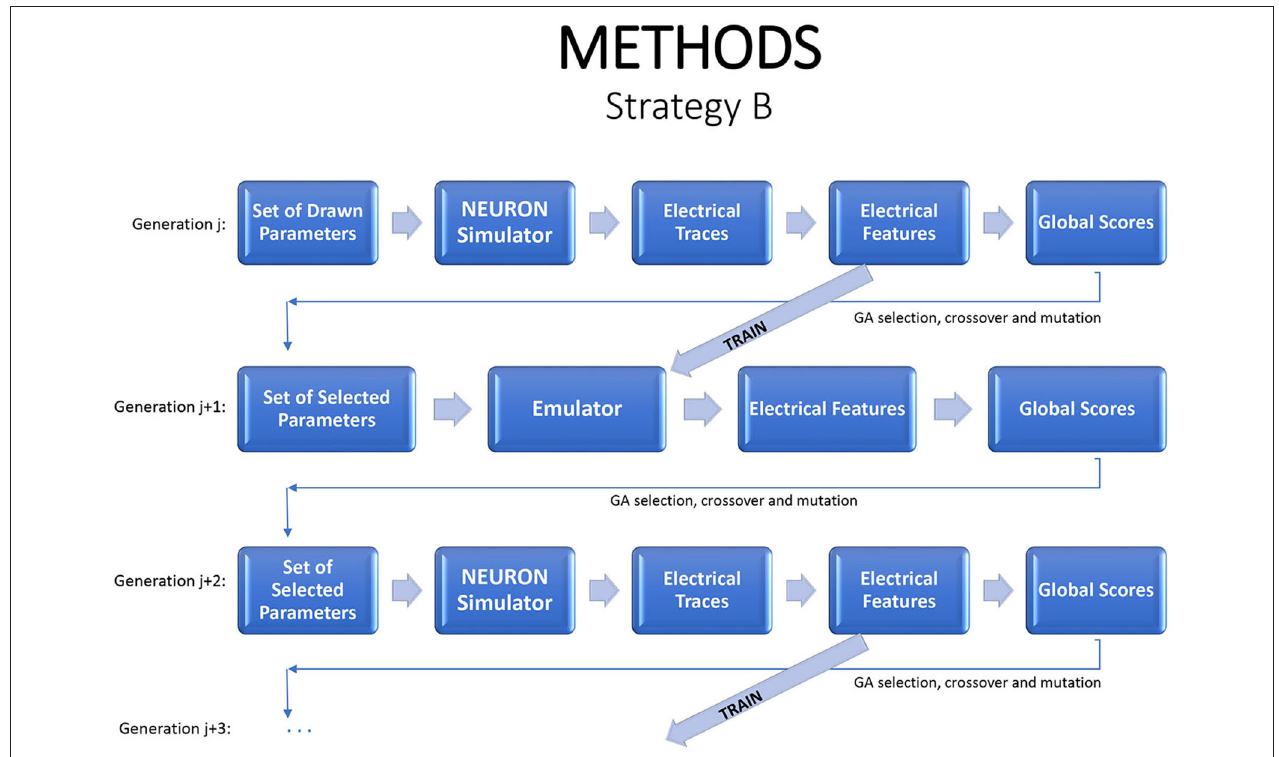
FIGURE 3 | A strategy for a modified genetic algorithm, simulating the individuals in one generation, using them to fit an emulator, and replacing the simulator runs by emulator predictions, for the following generation. Periodically a new generation should be evaluated by the simulator in order to update the emulator.